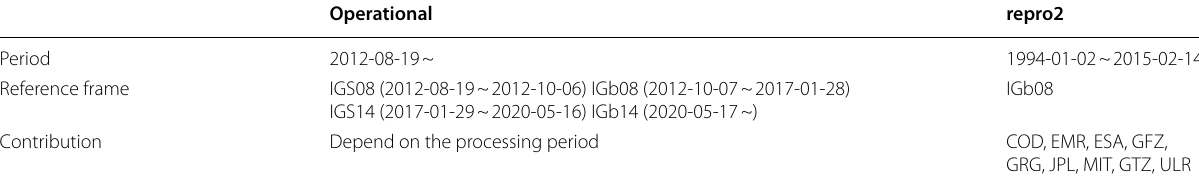
The AC names are abbreviated as follows: Center for Orbit Determination in Europe (COD), Natural Resources Canada (EMR), European Space Agency (ESA), Geoforschungszentrum (GFZ), Groupe de Racherche en Geodesie Spatiale (GRG), Jet Propulsion Labs (JPL), Massachusetts Institute of Technology (MIT), GFZ contribution to the IGS TIGA project (GTZ), Université de la Rochelle